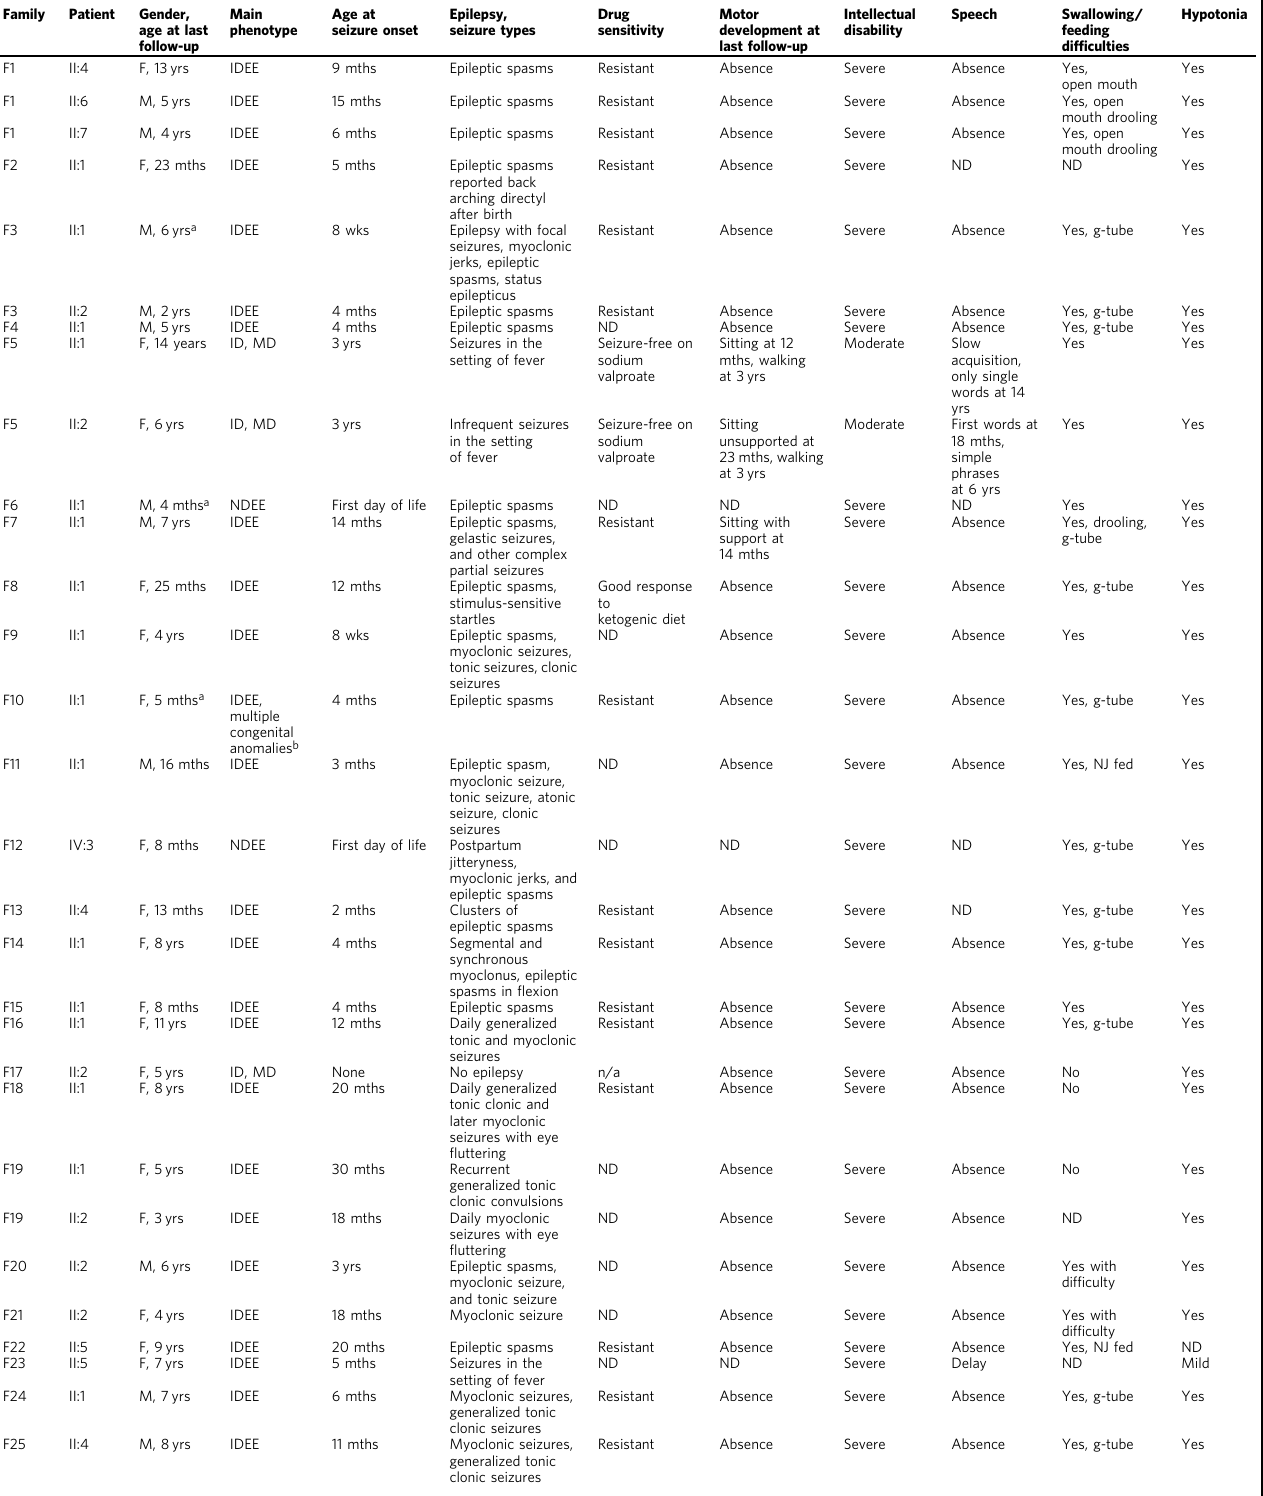
M male, F female, IDEE infantile developmental epileptic encephalopathy, NDEE neonatal onset developmental epileptic encephalopathy, MD motor disorder, n/a not applicable, ND non-determined, ID intellectual disability, g-tube gastrostomy tube, NJ nasojejunal, wks weeks, mths months, yrs years. a Age at death. b Multiple congenital anomalies in F16-II:1: prenatal polyhydramnios; multiple ocular anomalies (bilateral cataracts, multiple bilateral lens colobomas, bilateral microphthalmia, hypoplastic iris, iris and lenticular vascularization, bilateral anterior segment dysgenesis, posterior synechiae bilaterally secondary to neovascularization); megacystis; neurogenic bladder; moderate hiatal hernia; camptodactyly of 3rd and 4th fi ngers and overriding 2nd and 4th digits on the right hand; long tapered fi ngers; skeletal survey showed overlapping of the parietal bones and mild elongation of the 2nd through 5th fi